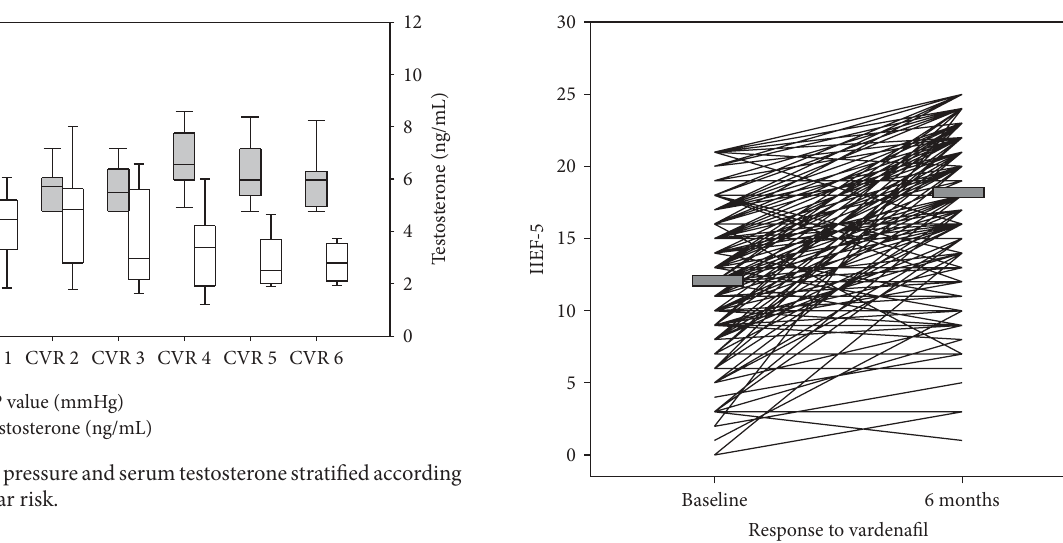
Figure 6: Response to vardenafil measured by the international index of erectile function